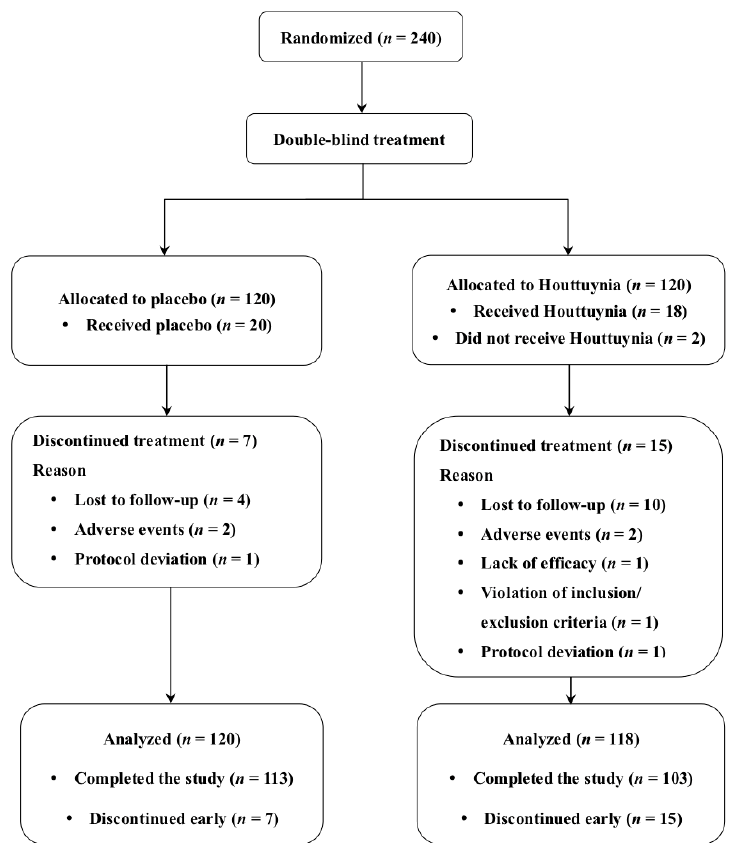
Figure 1. Subject flow chart.